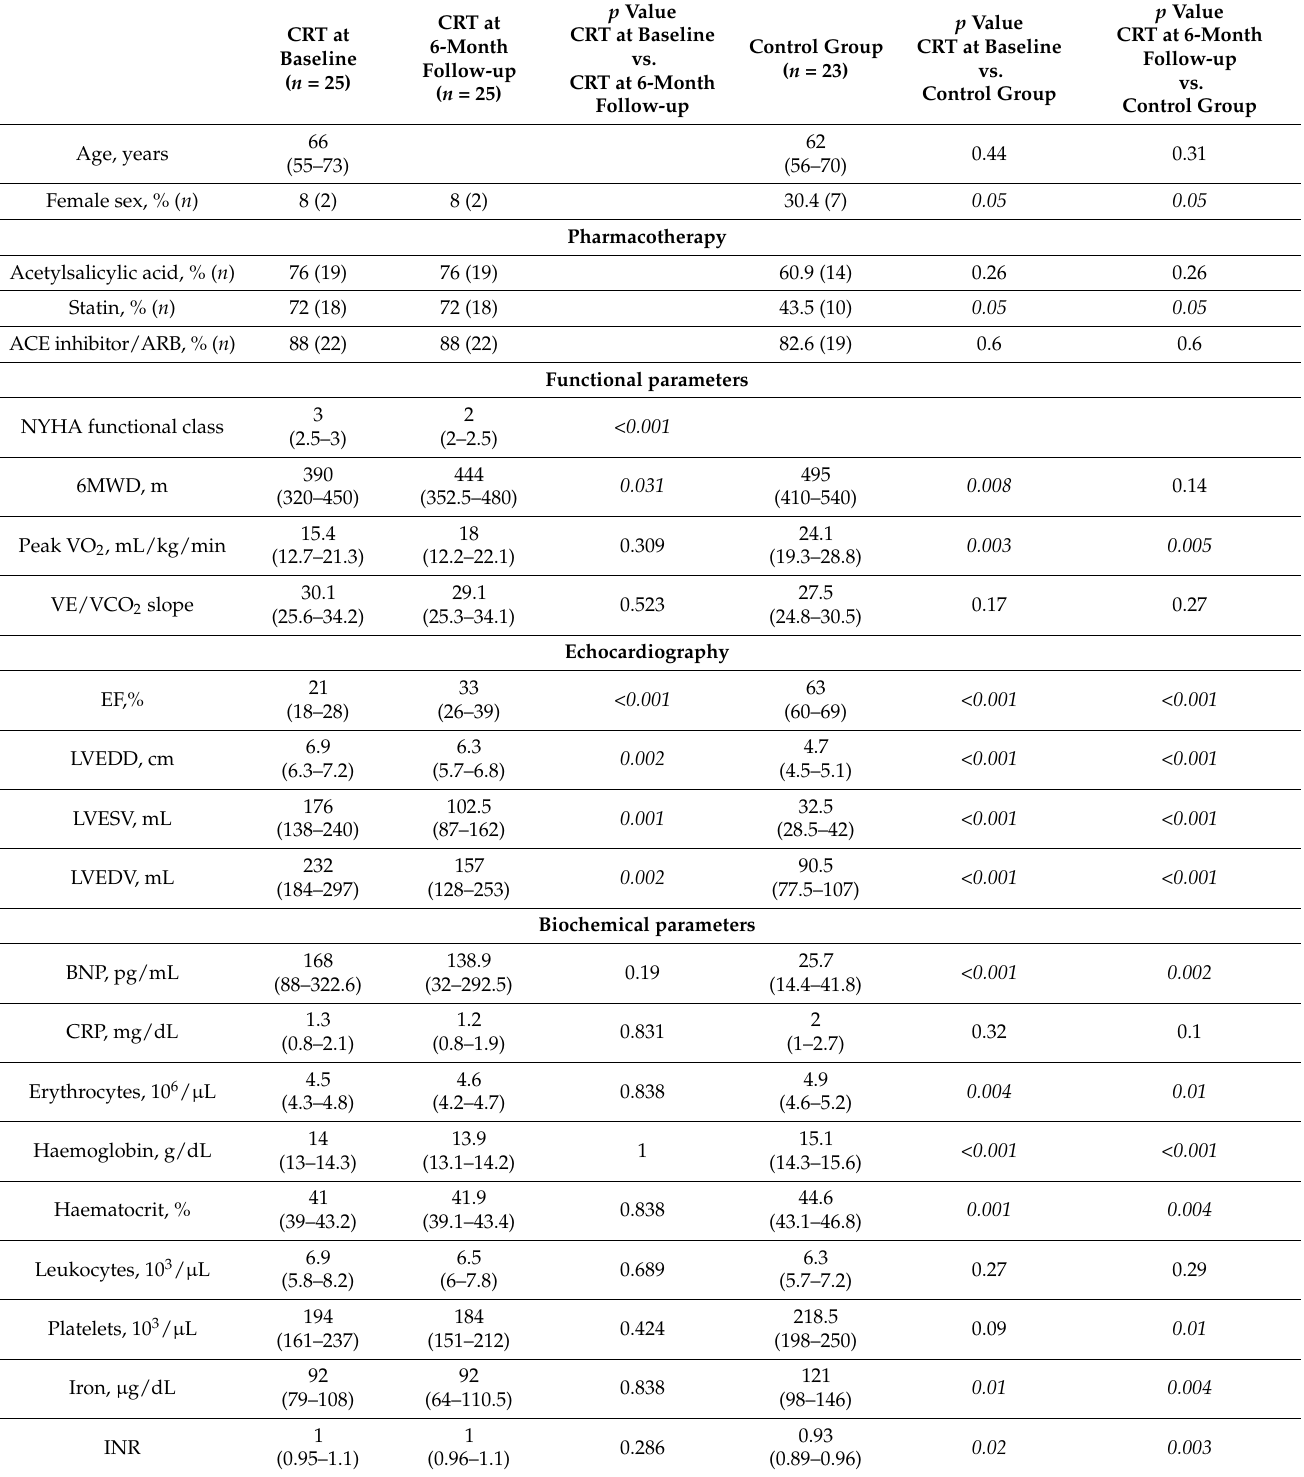
Table 2. Demographic, functional, echocardiographic, and biochemical characteristics of the heart failure patients with implanted CRT at baseline, at 6-month follow-up and control